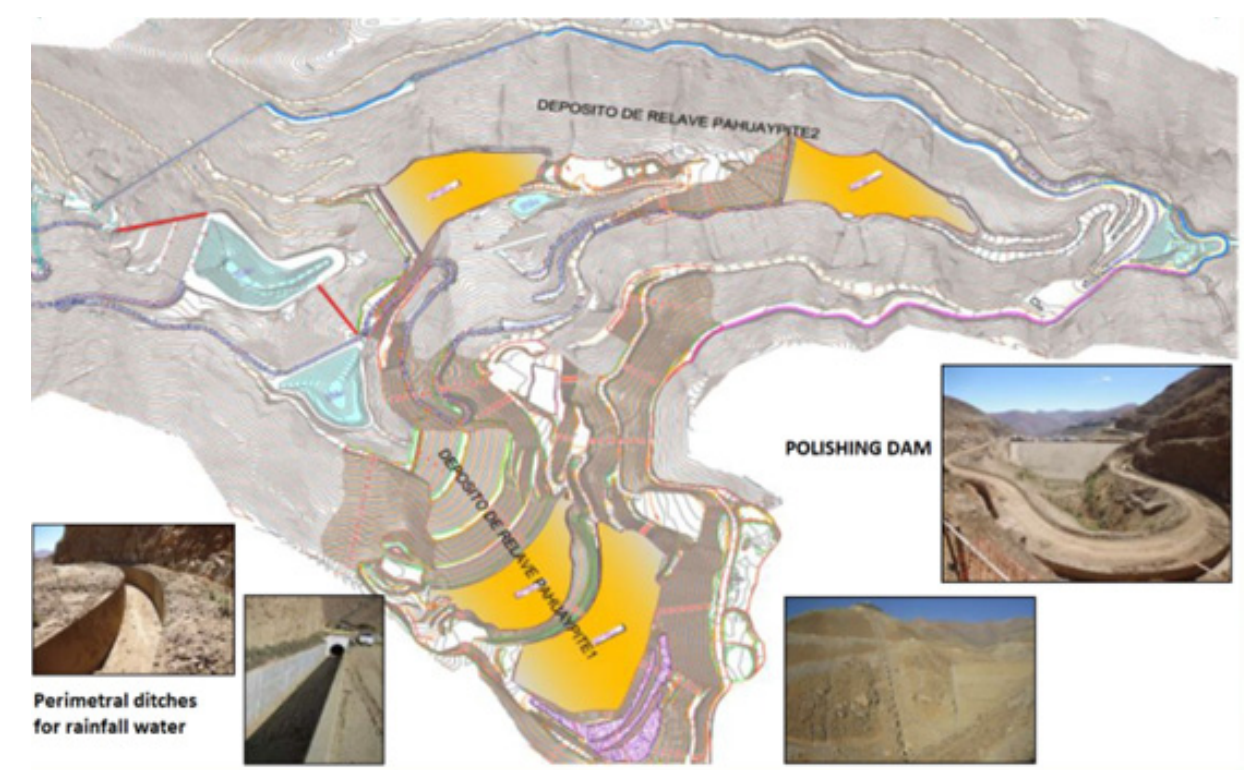
Figure 57. Cerro Lindo Filtered TSF Layout—Pahuaypite 1 TSF and Pahuaypite 2 TSF [20,21,25].